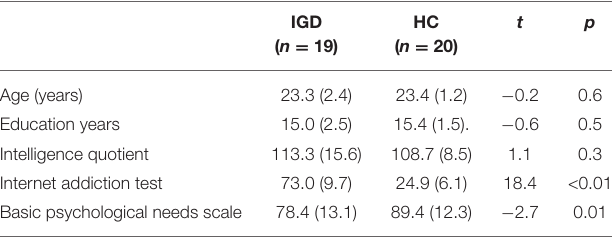
TABLE 1 | Demographic and clinical characteristics of individuals with internet gaming disorder (IGD) and healthy control